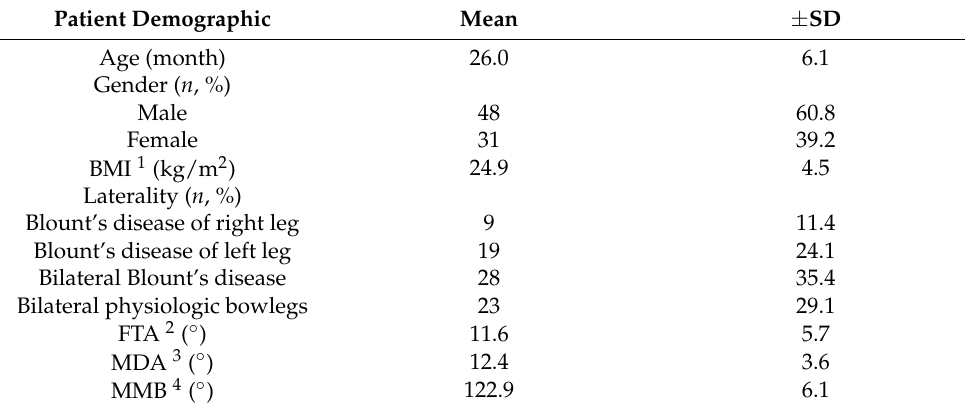
Table 1. Demographic and Clinical Characteristics of the 79 Included